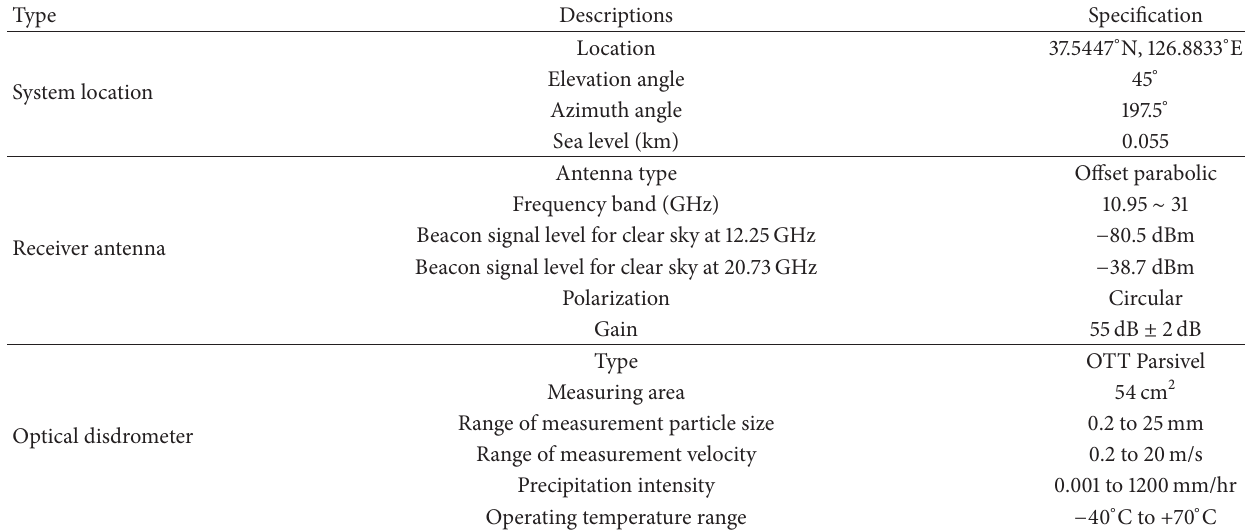
Table 2: Specifications of the 12.25 and 20.73 GHz links for Koreasat 6 satellite link [19].